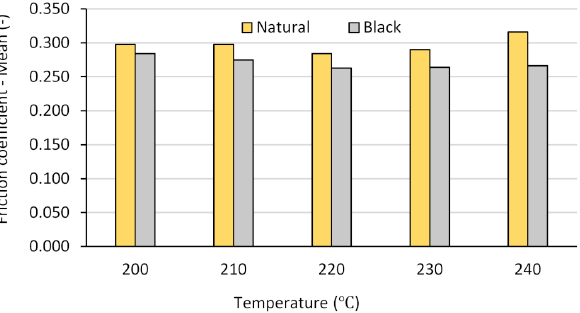
Figure 6. The variation of the mean value of the friction coefficient with the printing temperature and the filament